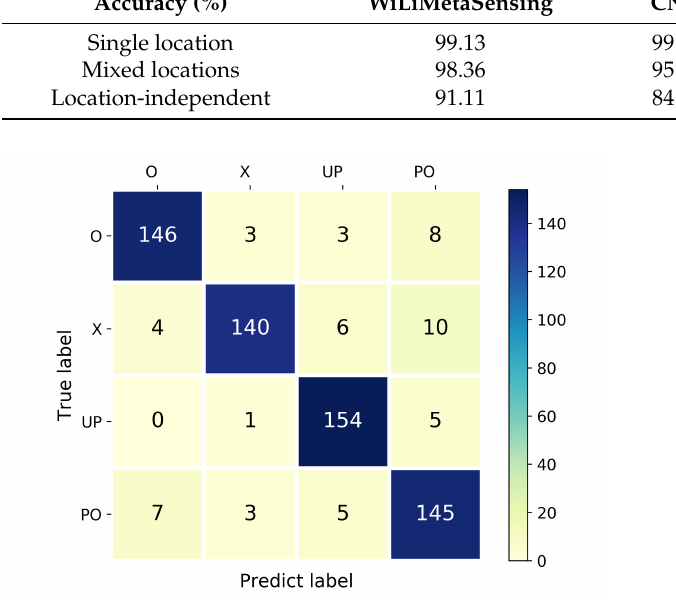
Figure 13. The confusion matrix of location-independent human activity